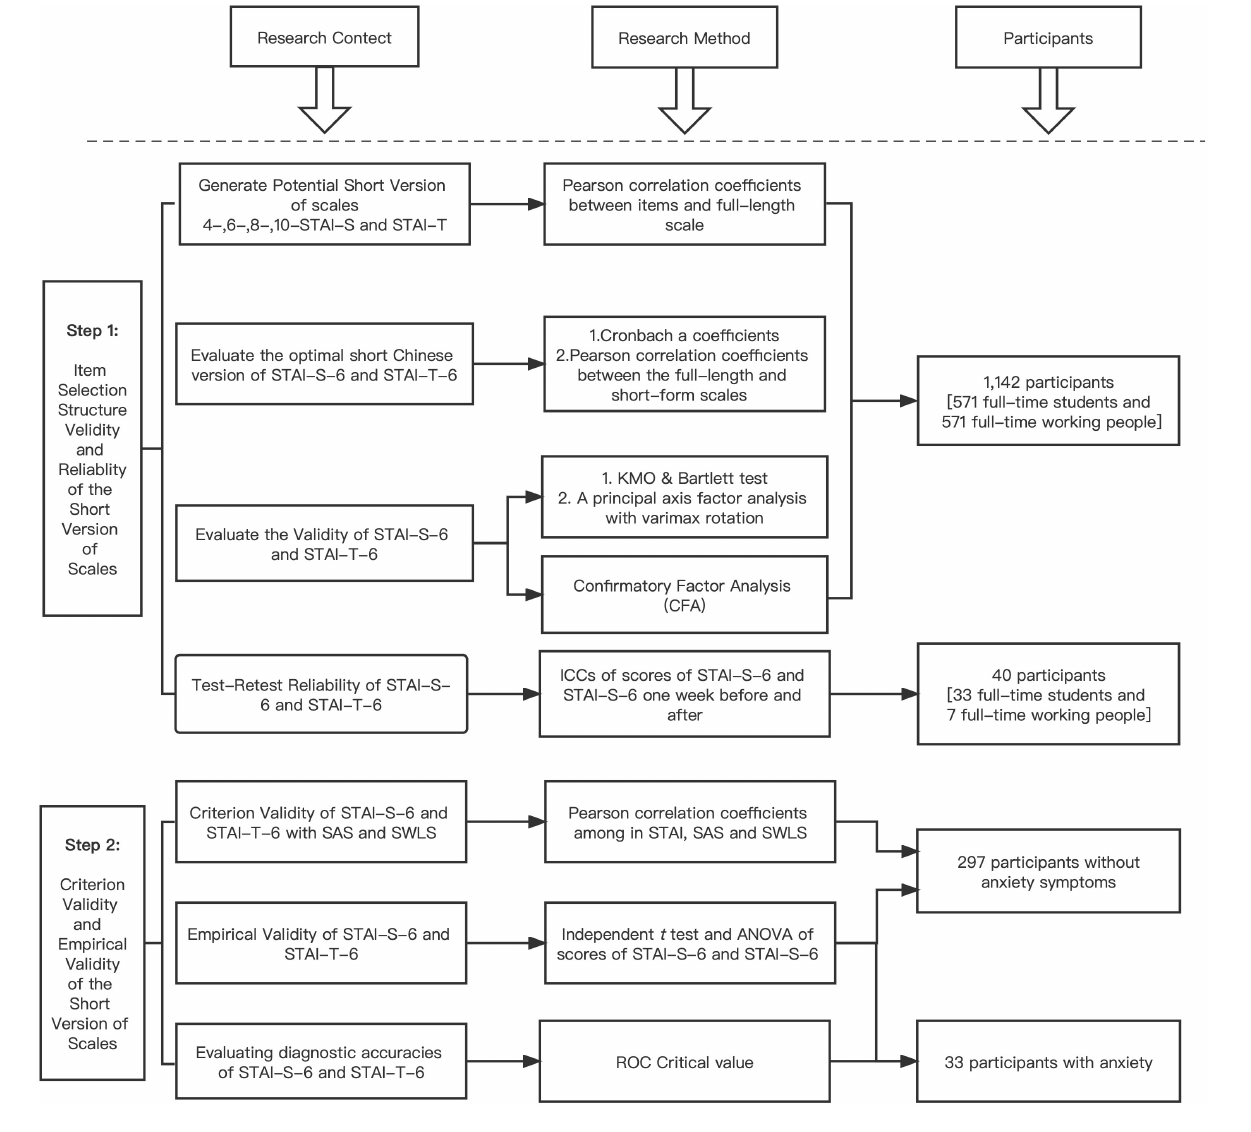
FIGURE 1 | Prosess